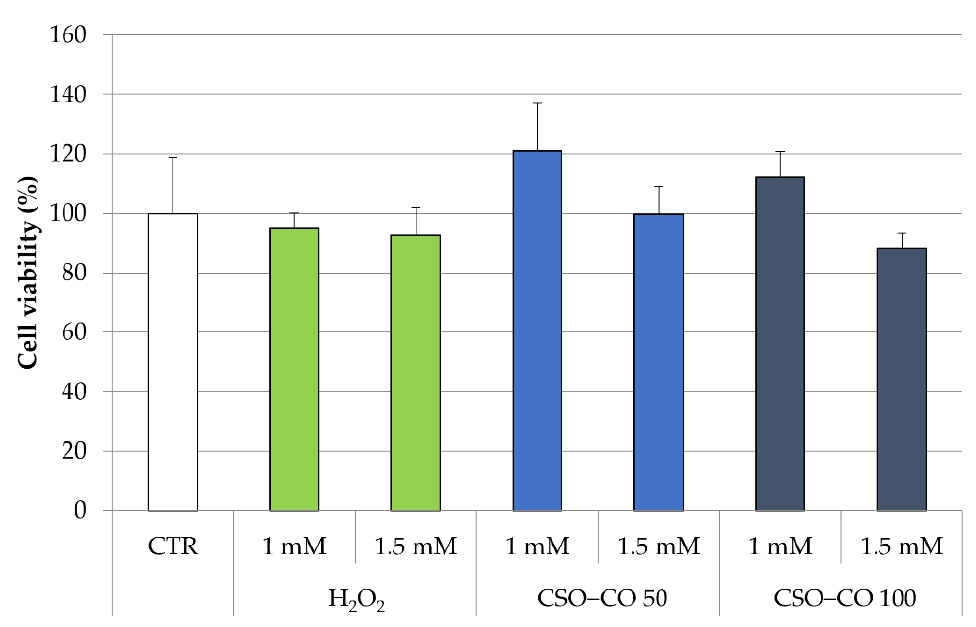
Figure 9. Cell viability (%) of fibroblasts treated with H 2 O 2 with and without a previous treatment with CSO–CO 50 and CSO–CO 100, both diluted to 1:20 ( v / v ) (mean ± sd; n = 4). All the cells, even those treated with H 2 O 2 only, maintained a high level of viability. The cells treated with H 2 O 2 (1 mM) with and without a previous treatment with CSO–CO 100 NE (1:20 v / v ) were studied for ROS presence using the EPR test. Fibroblasts subject to the same treatment with H 2 O 2 and with 3 h of protective treatment with α -tocopherol encapsulated in CSO at a concentration of 10 µM, as previously described and characterized [29], were tested under the same conditions for comparison purposes.